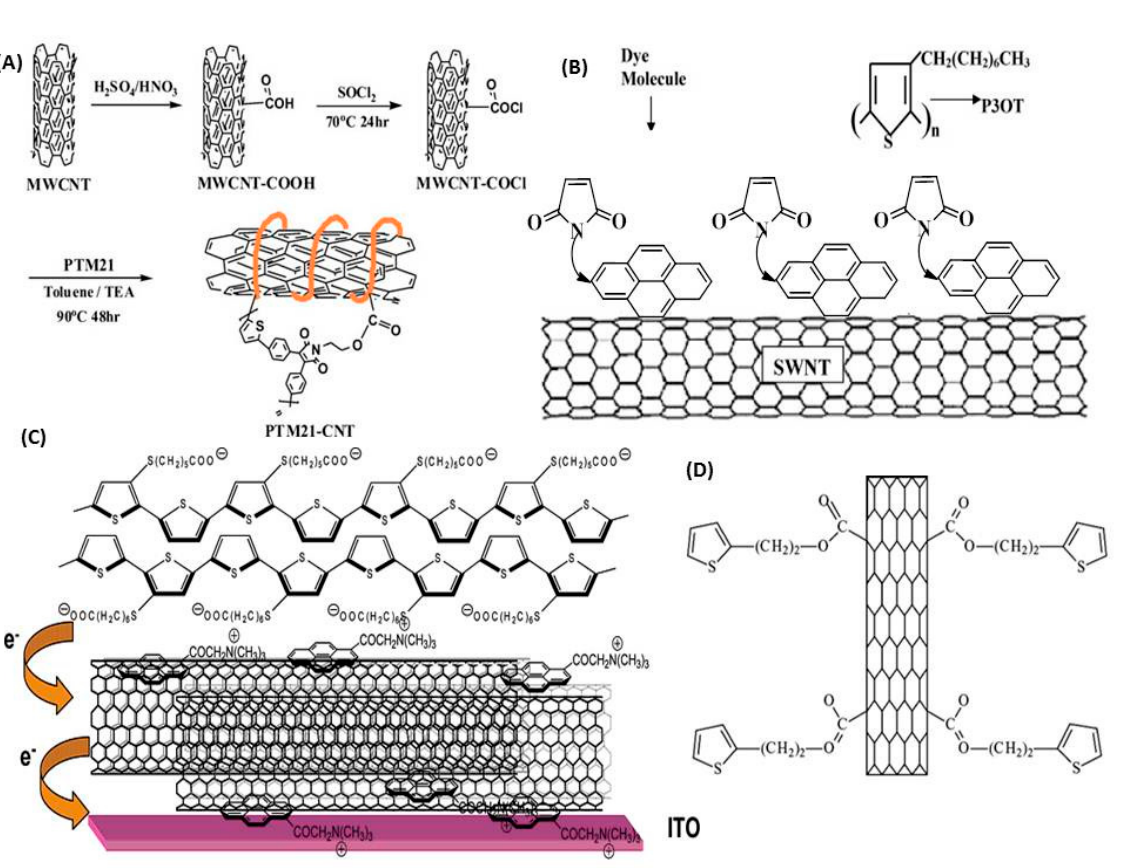
Figure 3. Various CNT functionalization approaches to improve incorporation of CNTs in polymer layers. Such approaches have been used both for the hole harvesting or active layers of the cells. ( A ) Synthesis scheme of PTM21-CNT, carbon nanotubes functionalized with a maleimide–thiophene copolymer; ( B ) Chemical structure of poly(3-octylythiophene) (P3OT), single walled nanotube (SWNT), N -(1-pyrenyl)maleimide (PM), detailed scheme of the dye molecule (PM) attachment to the SWNT surface via pi-stacking; ( C ) Schematic representation of electron transfer events in modified ITO electrodes bearing a single SWNTâpyrene+/PSCOOH sandwich layer; baselayers of PDDA and PSS are omitted from the sketch; ( D ) Schematic representation of the SWNT-TIOPH structure. (A) Reproduced from [50] with permission; (B) adapted from [78] and reproduced with permission; (C) Reproduced from [79] with permission and (D) Reproduced from [34] with